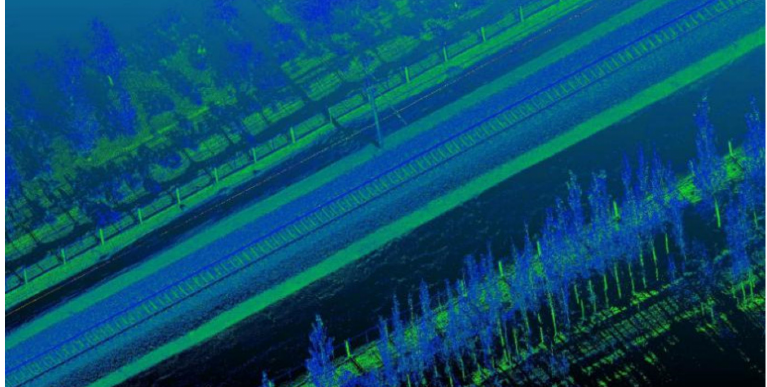
Figure 5. Original point